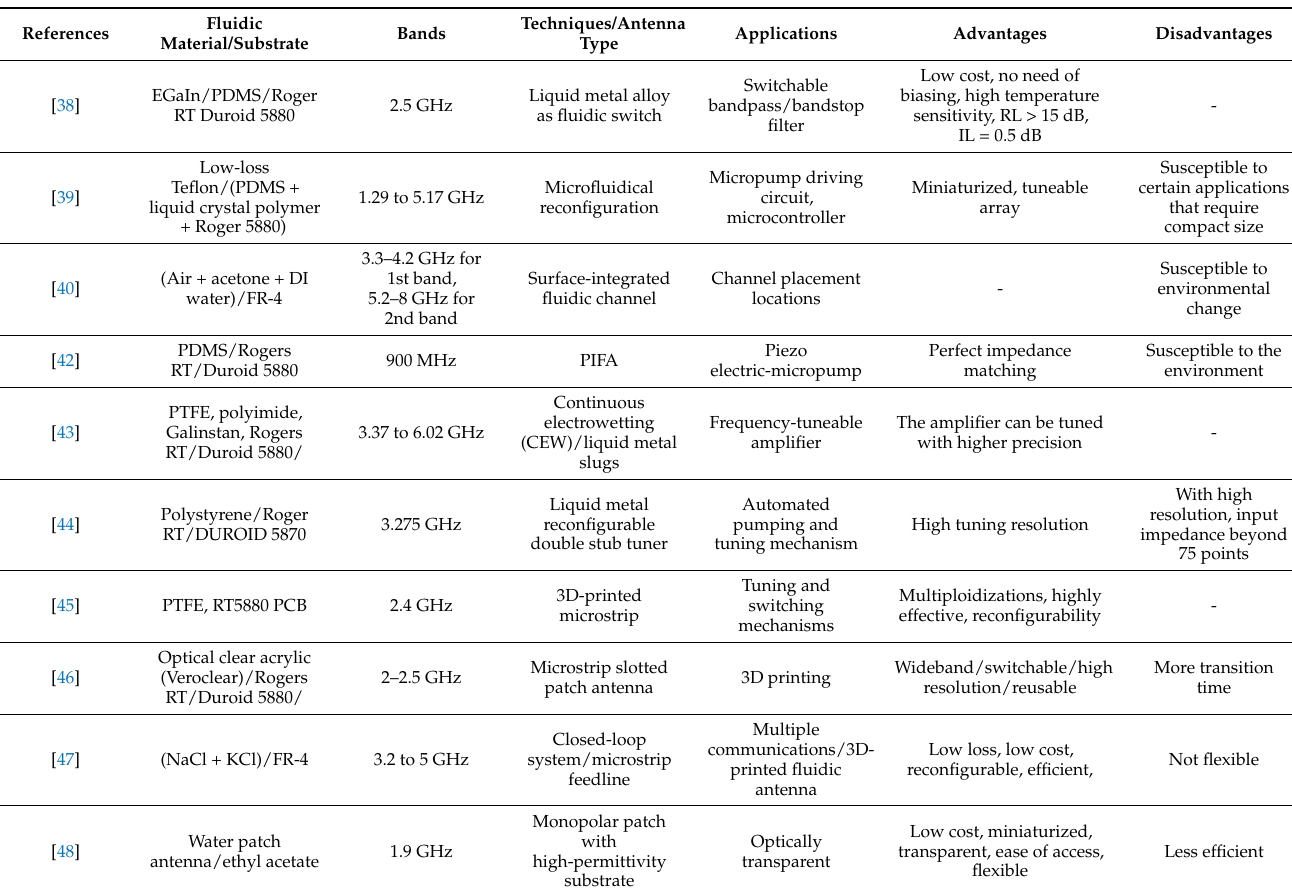
Figure 19. Miniaturized monopolar water patch antenna. Table 3. Comparison analysis of fluidic antennas.